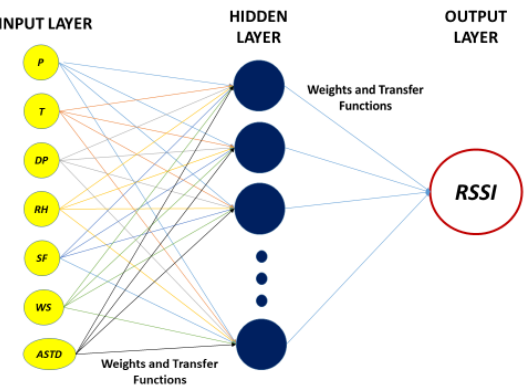
Figure 11. The multilayer perceptron network architecture for RSSI prediction.